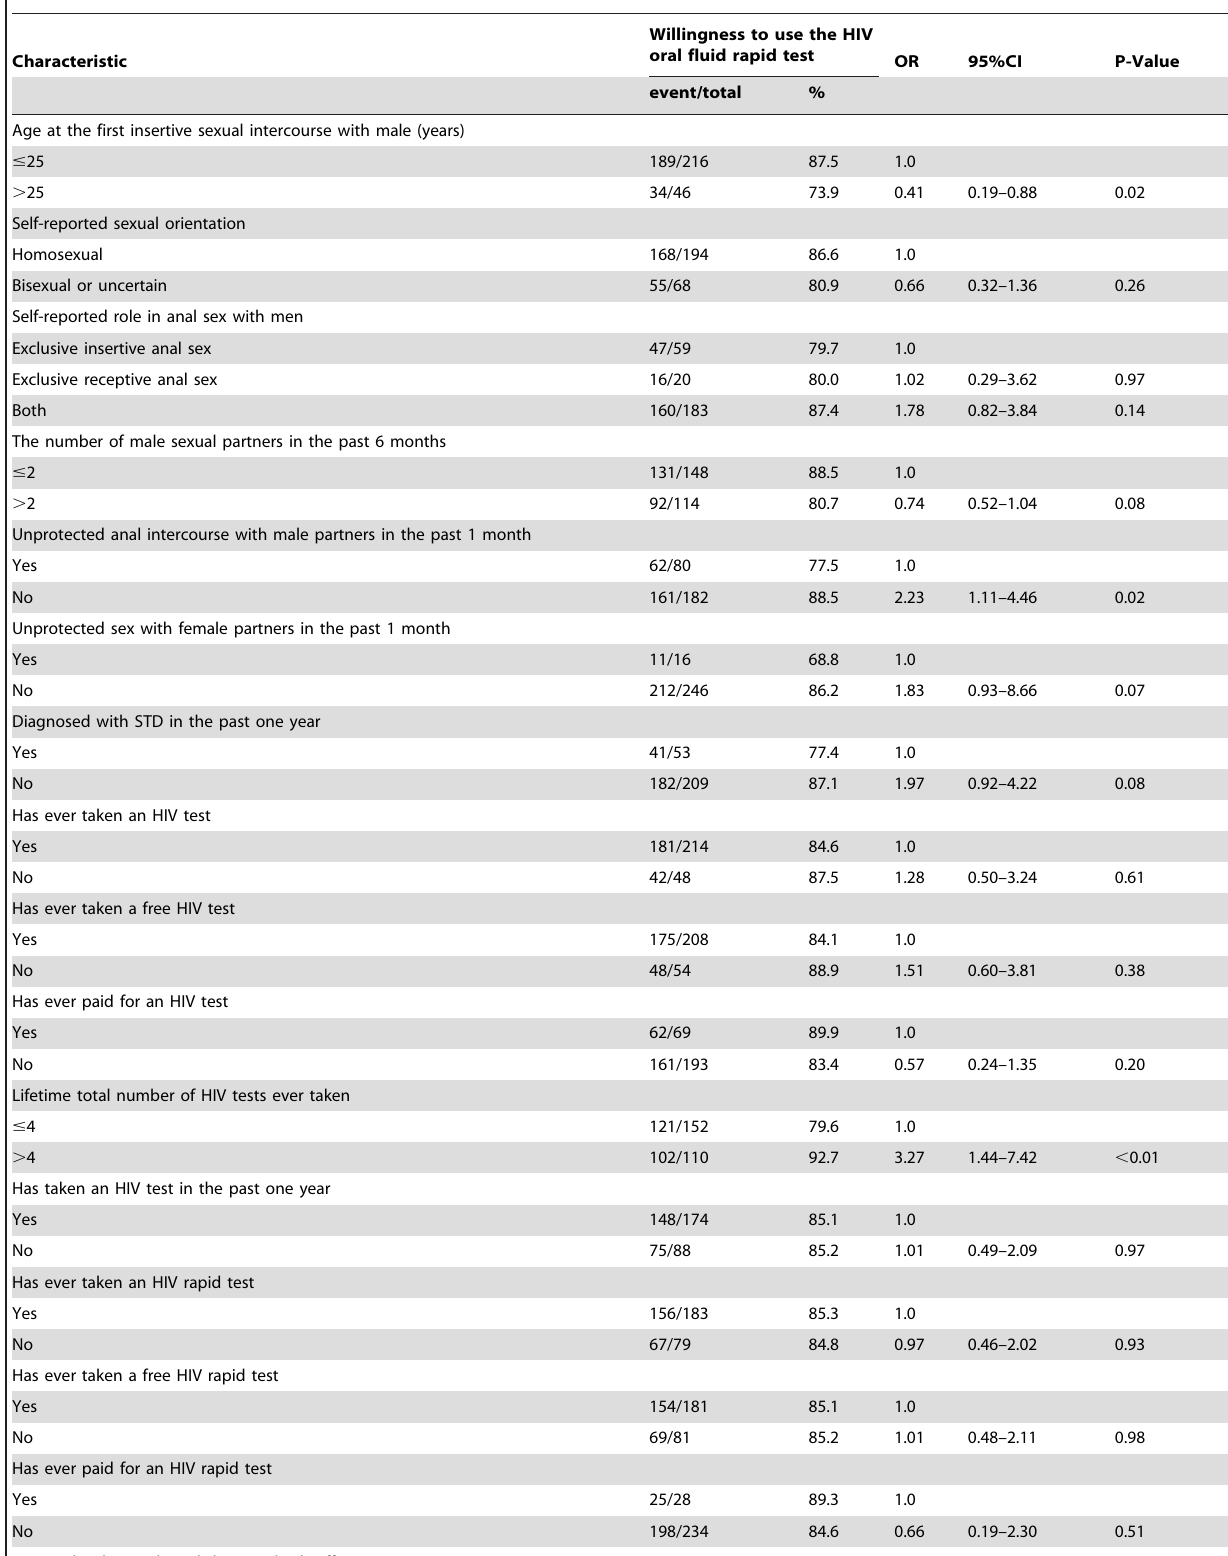
Table 2. Associations between willingness to use oral fluid HIV rapid test and sexual behaviors and, HIV testing among Men who have sex with men in Beijing,